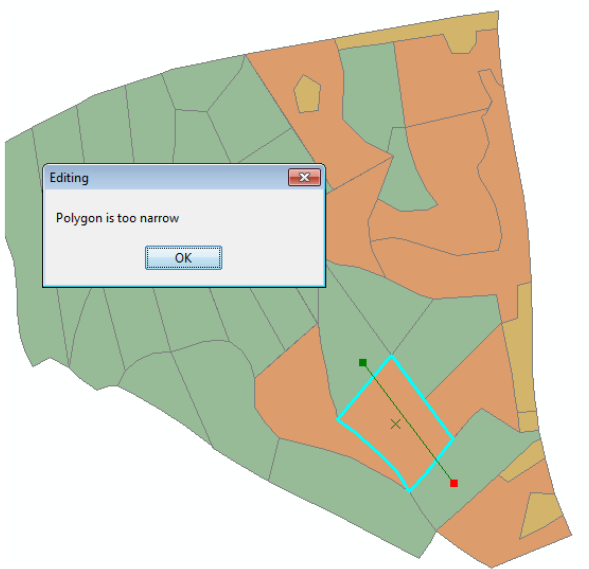
Figure 3. An example of the automatic checking process.